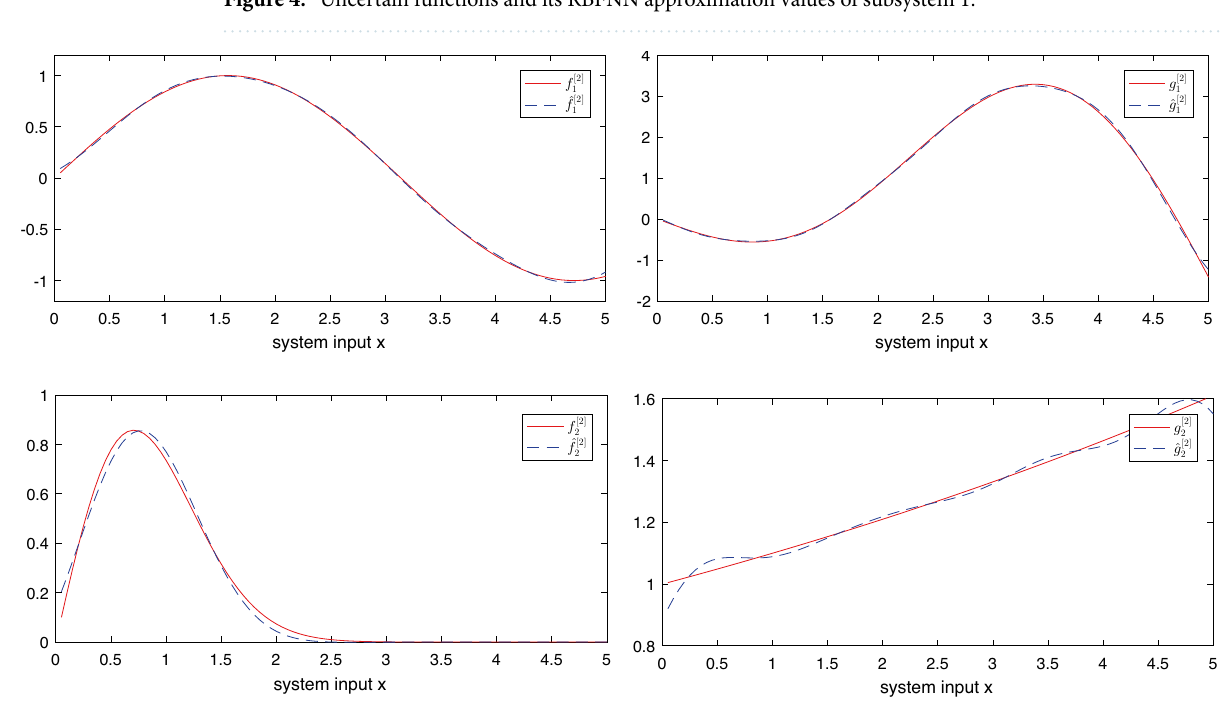
Figure 5. Uncertain functions and its RBFNN approximation values of subsystem